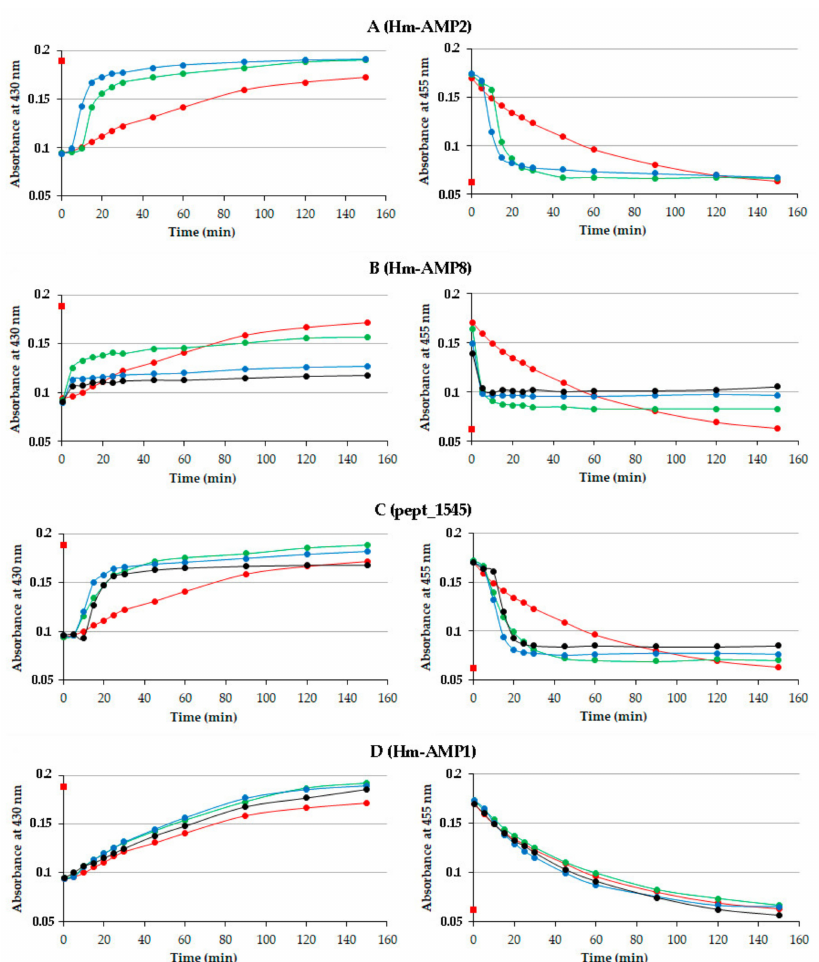
Figure 2. Time courses of spectral absorbance changes at 430 nm (indicative of MPO ground state) and 455 nm (indicative of Compound II) in the absence and presence of cationic antimicrobial peptides (CAMPs) in the system MPO/H 2 O 2 . The name of CAMP is given in parentheses after the panel designation ( A – D ). H 2 O 2 (100 µ M) was added to MPO (2 µ M heme) or MPO preincubated with peptides at different peptide/heme molar ratios for 5 min in 10 mM Na-phosphate buffer, pH 7.4. Spectra were taken before and 0.25 min, 5 min, 10 min, and so on after adding H 2 O 2 . The initial absorbance values (before H 2 O 2 addition) are shown as a red square marker. Red curve—MPO in the absence of peptides; green curve—peptide/heme ratio of 15 mol/mol; blue curve 3—peptide/heme ratio of 75 mol/mol, except for Hm-AMP2 for which it was 45 mol/mol; black curve—peptide/heme ratio of 100 mol/mol for Hm-AMP8 or 100 mol/mol and 125 mol/mol for pept_1545. Data are representative of three independent